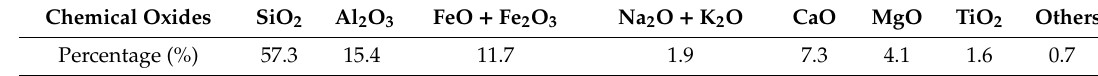
Table 4. Chemical compositions of chopped